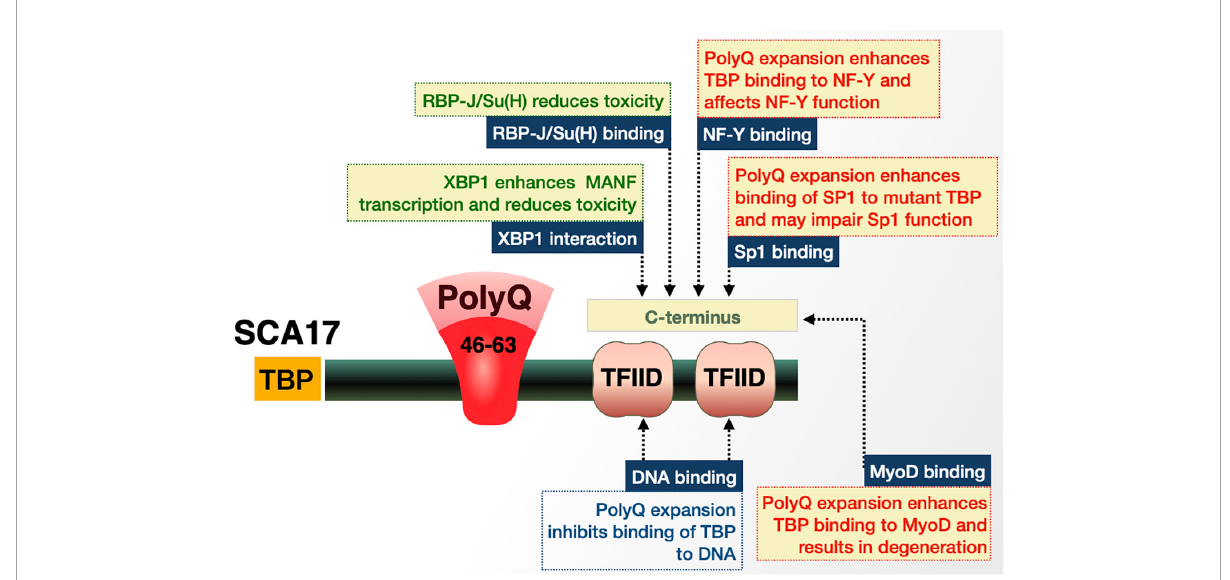
FIGURE10 Graphic representation of the SCA17 protein, its domains, and interactions. Details are in the main